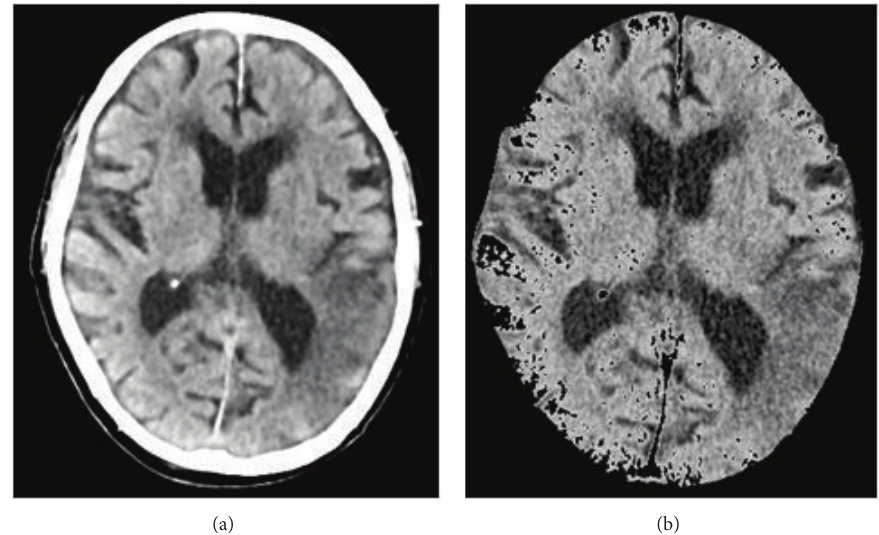
Figure 3: (a) Image after performing anisotropic diffusion and (b) the brain tissue image.